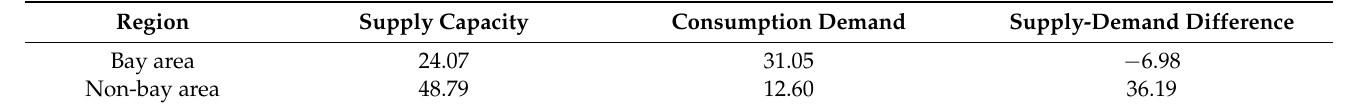
Table 7. Contrast of supply and demand of ecosystem services between bay area and non-nay area in 2015